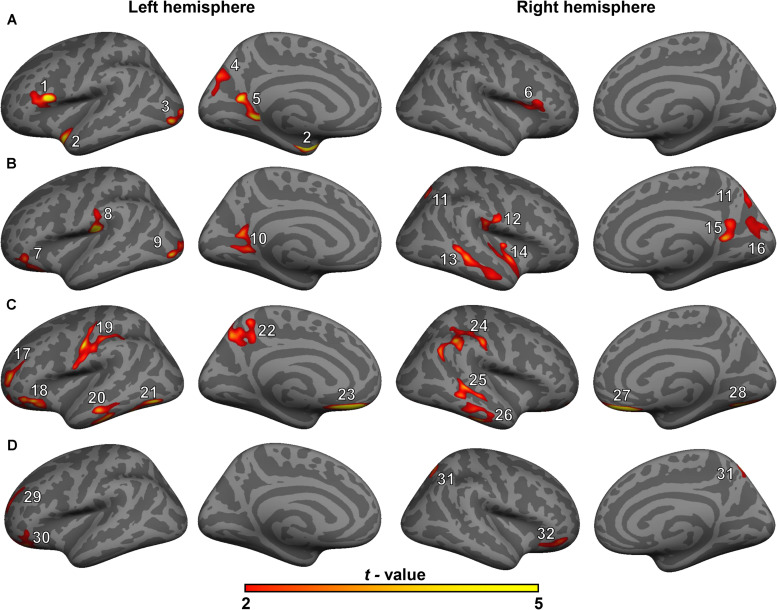
Surface maps of significant differences in cortical volumes between healthy controls (HCs) and patients with mild cognitive impairment (MCI) (A), between HCs and patients with type 2 diabetes mellitus and MCI (T2DM-MCI) (B), between patients with MCI and patients with T2DM-MCI (C), and between patients with T2DM and patients with T2DM-MCI (D). Differences in cortical volume are presented on inflated cortical surfaces (clusterwise-corrected p-value < 0.05). Dark gray indicates gyri; light gray indicates sulci. The color bar represents t-values ranging from 2 to 5 (red to yellow). The numerals refer to the cluster numbers listed in Table 2.